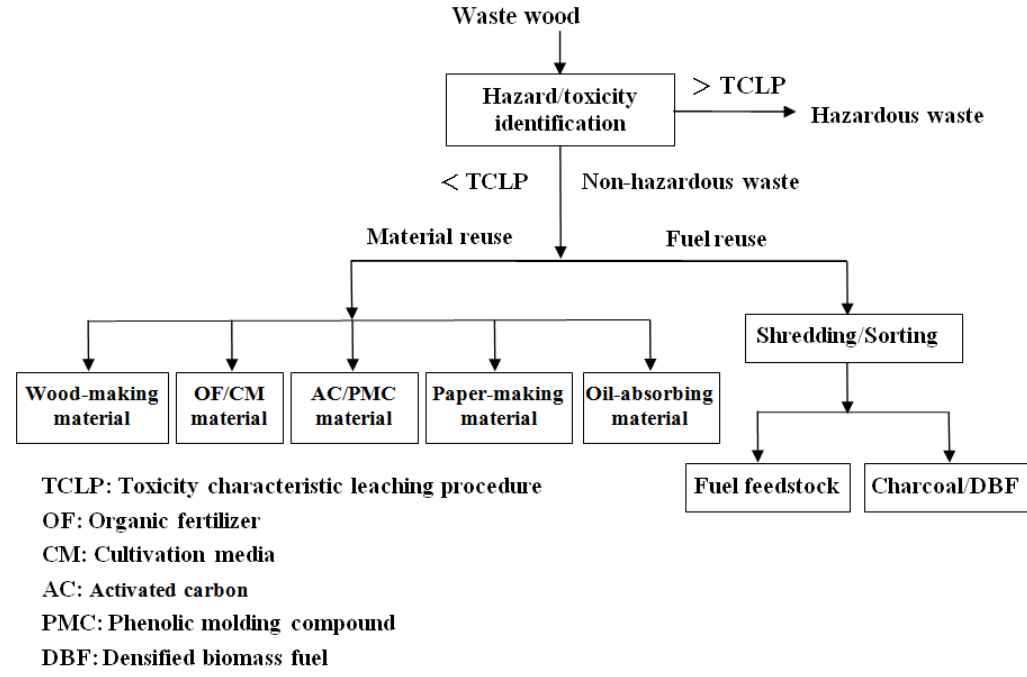
Figure 2. Outline flowchart of waste wood reuse for material and fuel utilization according to the Waste Management Act in